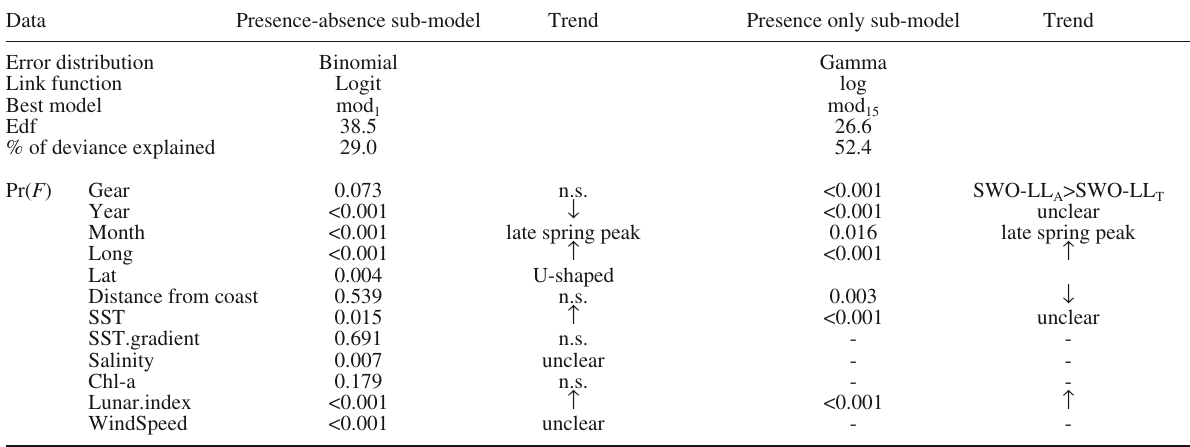
Table 5. – Summarized results of the best models selected for the presence-absence and presence only sub-models data of bluefin tunas caught in the swordfish long-line fishery of the eastern Mediterranean Sea. Pr( F ) refers to the p-values from an ANOVA F-ratio test; Edf are the estimated degrees of freedom. An upwards arrow indicates that the dependent variable increases as the independent one increases. A downwards arrow indicates that the dependent variable decreases as the independent one